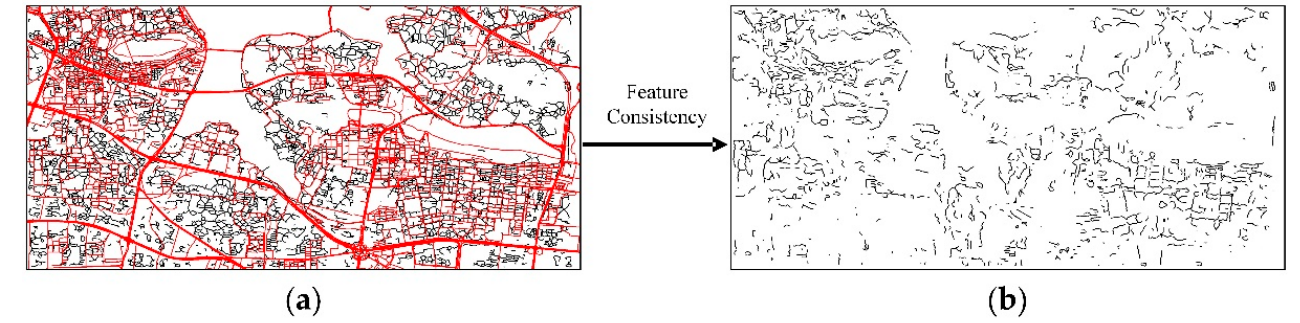
Figure 15. Experiments of feature consistency: ( a ) skeleton lines overlay with OSM (the red part is OSM roads, and the black one is the skeleton); ( b ) retained skeleton lines.